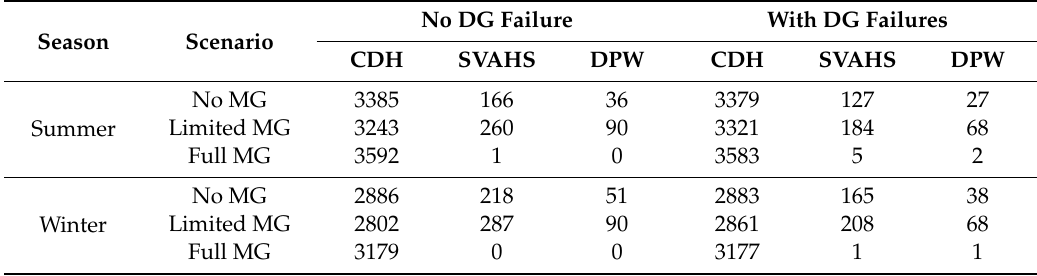
Table 8. Mean diesel fuel consumption (gallons) of the system with CDH PV in 3 days outages. Season